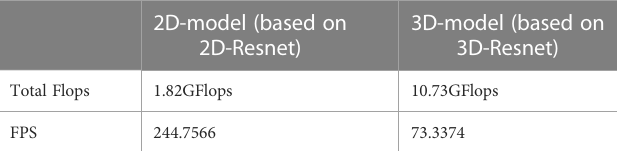
TABLE 3 The Total Flops and FPS between the 2D and 3D